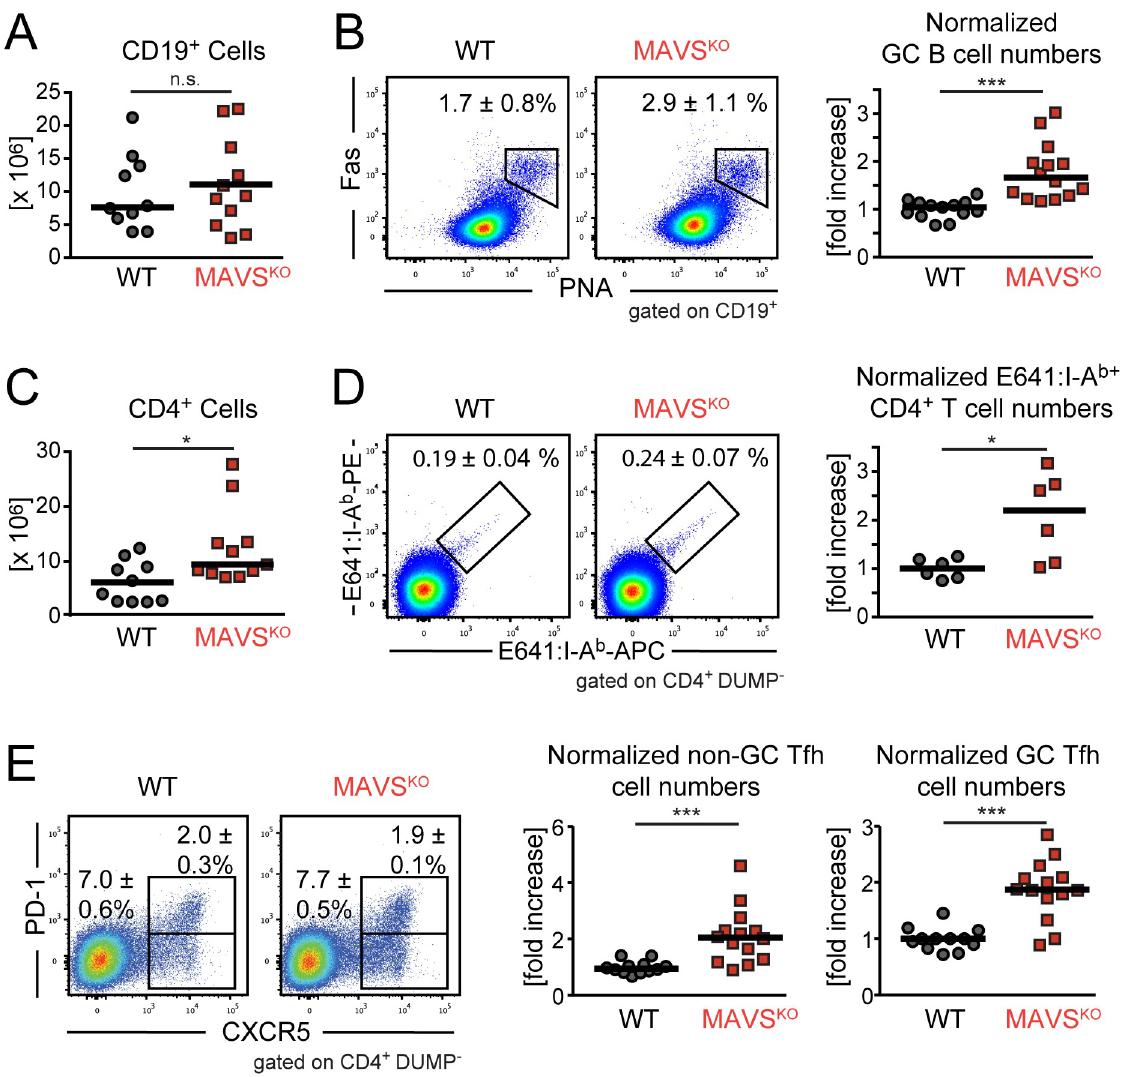
Fig 4. Enhanced GC B and CD4 + T cell response to RWN in MAVS KO mice. The cellularity of the dLNs from MAVS KO and MAVS WT mice was analyzed 8 days post RWN infection (10 5 pfu/footpad) by flow cytometry. (A) Total numbers of CD19 + B cells. (B) Left panels: Frequency of Germinal Center (GC) B cells. Right panel: Total GC B cell numbers of 5 experiments normalized to the average of MAVS WT mice in each experiment. (C) Absolute number of CD4 + T cells. (D) Left panels: Frequency of E641:I-A b class II tetramer + CD4 + T cells specific for the immunodominant E641 epitope derived from WNV-E. Right panel: Total E641:I-A b+ CD4 + T cells numbers of 3 experiments normalized to the average of MAVS WT mice in each experiment. (E) Left panels: Frequency of non-GC CXCR5 + PD-1 - T follicular helper (Tfh) cells and CXCR5 + PD-1 + GC Tfh cells. Right panel: Total Tfh cell numbers of 5 experiments normalized to the average of MAVS WT mice in each experiment. Frequencies are shown as mean ± SEM. Cell numbers: Each dot is one mouse, lines are the medians. � , p < 0.05; ��� ; p < 0.0005; n.s., not significant; Mann-Whitney test. mice (Fig 4C). CD4 + T cells specific for the immuno-dominant WNV epitope E641 were pres- ent in similar frequencies in MAVS KO and MAVS WT mice as shown by staining with E641: I-A b MHC class II tetramers (Fig 4D). However, as the CD4 + T cell compartment was enlarged in MAVS KO mice, these mice contained significantly more E641:I-A b+ CD4 + T cells in the dLNs than MAVS WT controls (Fig 4D). Similarly, the frequency of both CXCR5 + PD-1 - non- GC Tfh cells and CXCR5 + PD-1 + GC Tfh cells did not change in MAVS KO mice but the